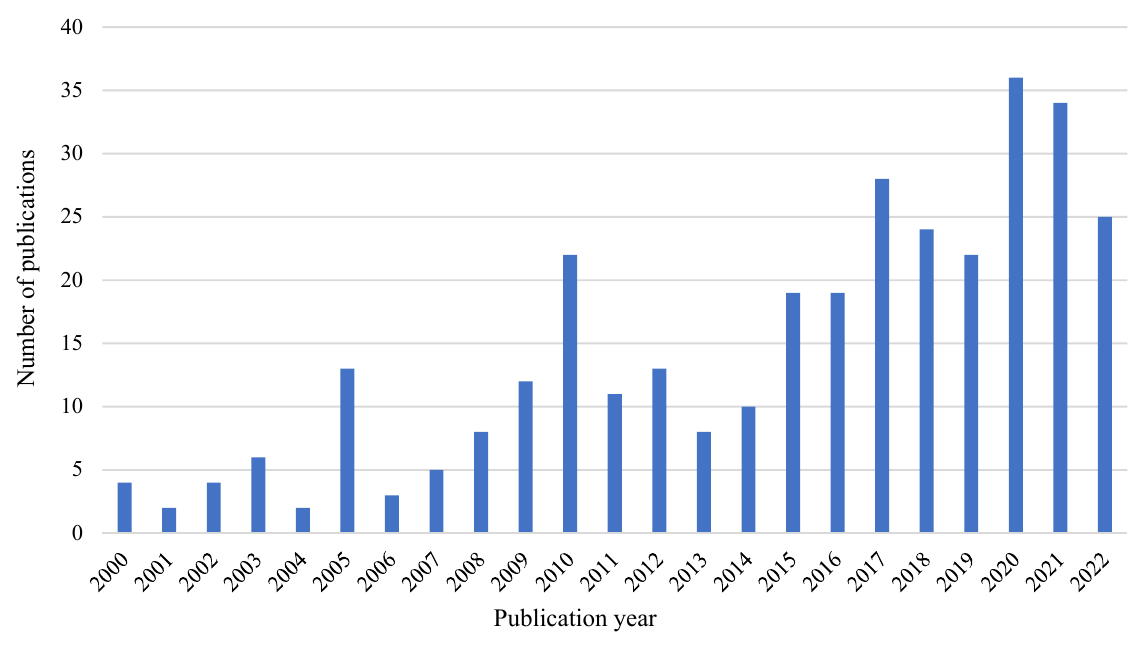
Figure 2. Annual publication trends of articles from 2000 to 2022 (October).